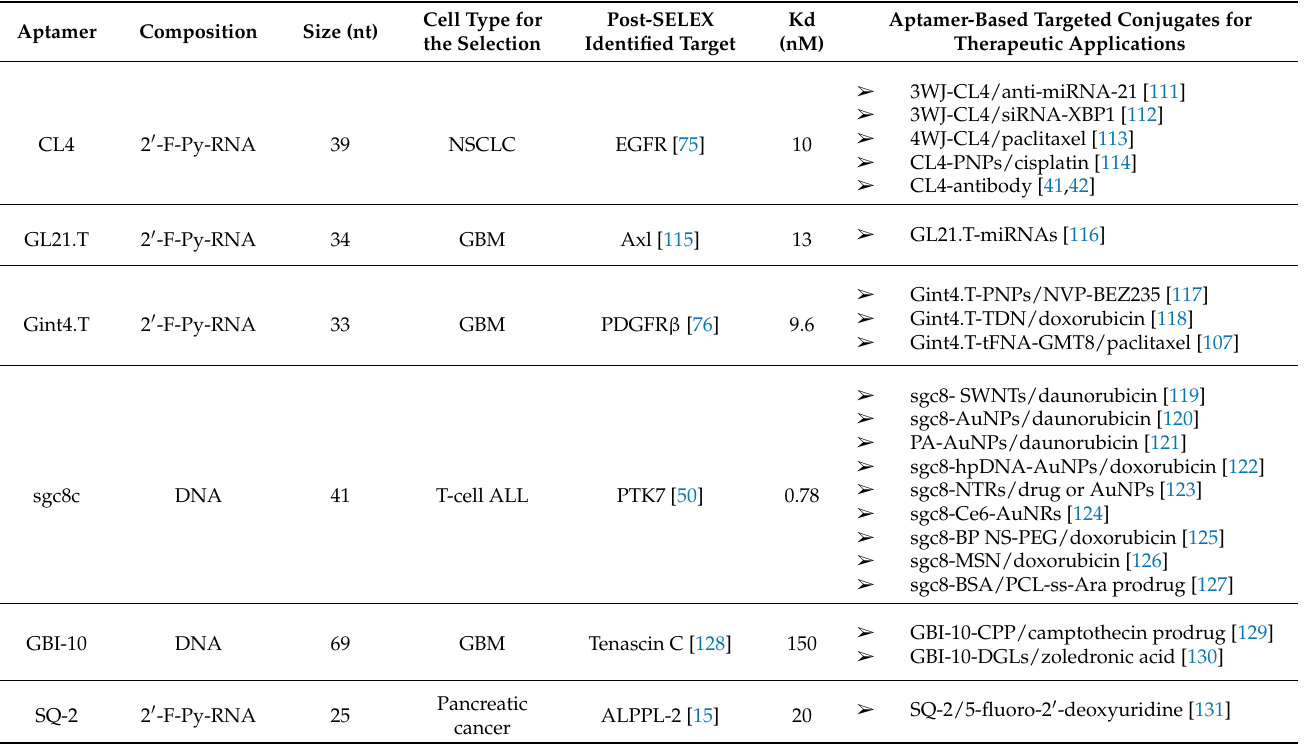
Table 1. Aptamer-based conjugates for targeted drug delivery in